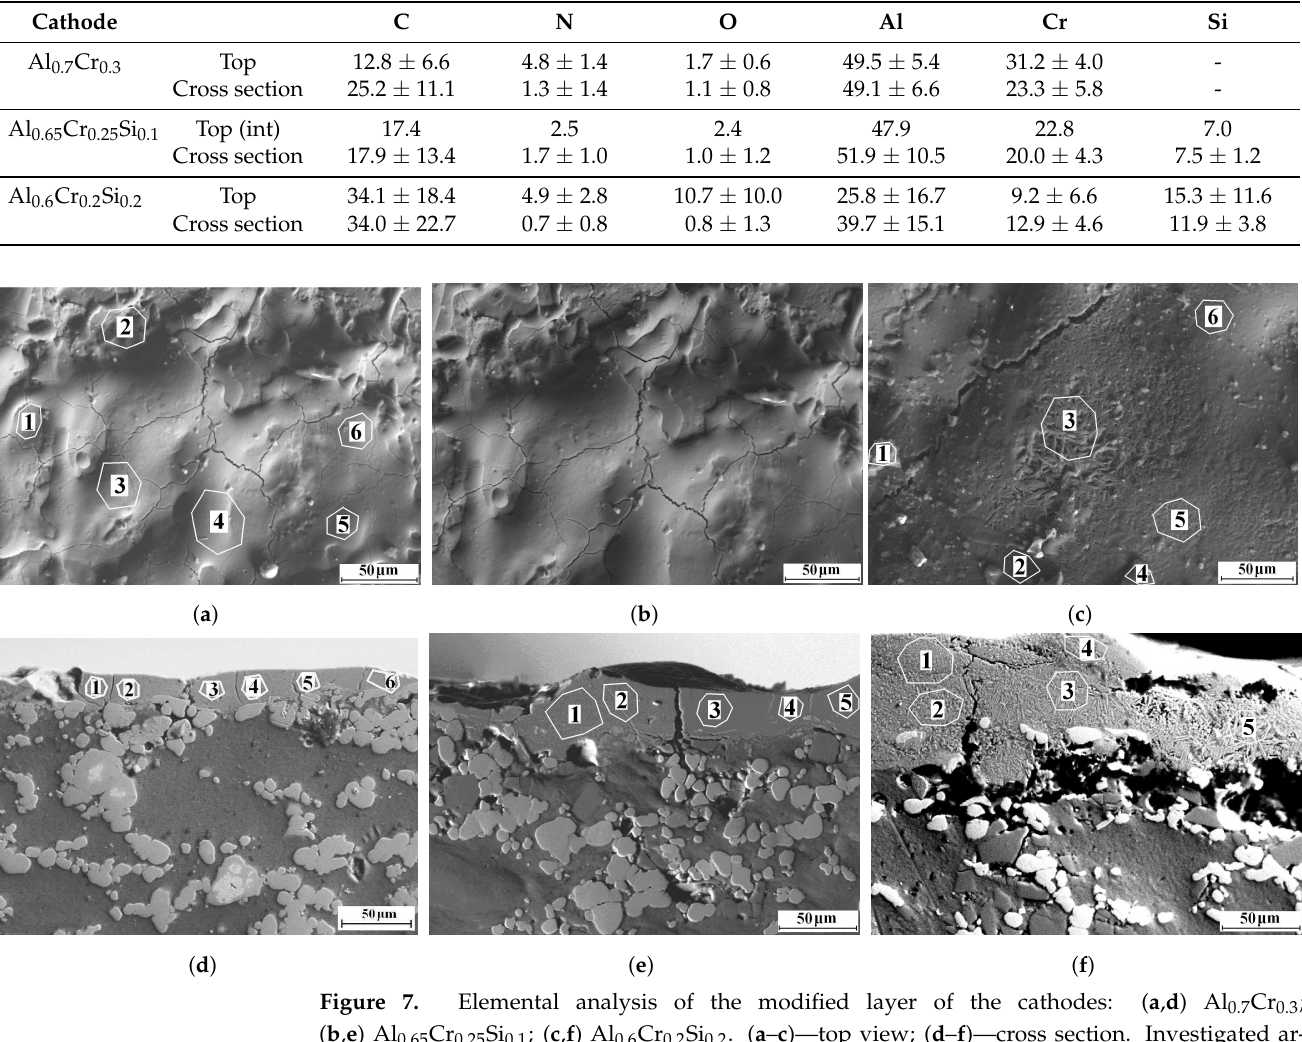
Table 2. The distribution of the elements in the modified layer (top and cross section).